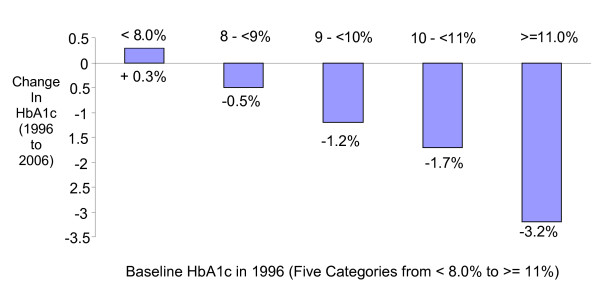
Mean change in HbA1c between 1996 and 2006, by HbA1c level in 1996 (n = 1772).